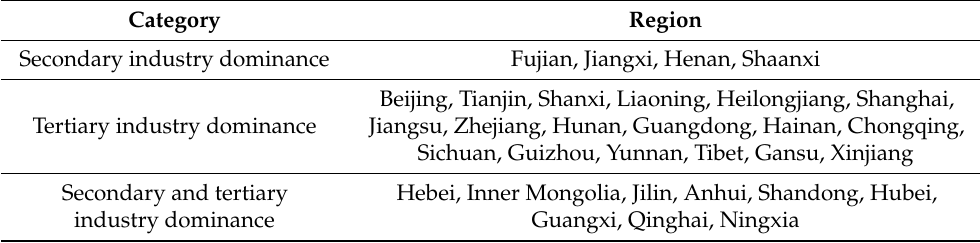
Table 7. Regions classified by industry orientation. Category Region Secondary industry dominance Tertiary industry dominance Secondary and tertiary industry